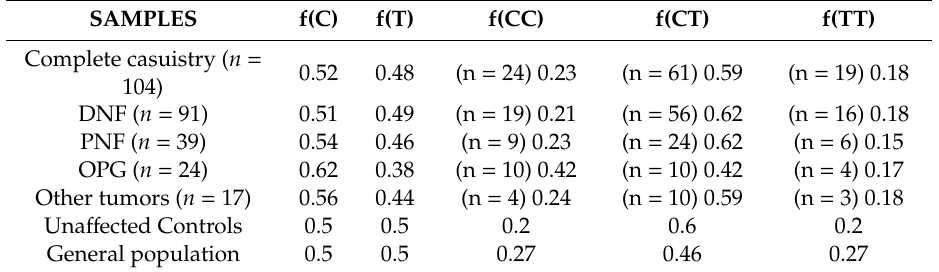
Table 2. Rs2151280 genotype frequency distribution in patients’ subgroups, according to the tumor